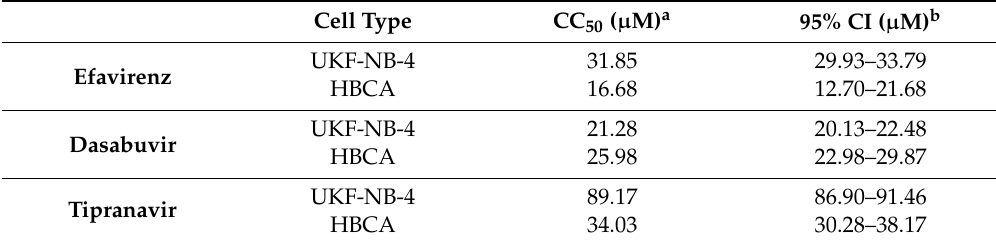
Table 3. Cytotoxicity characteristics of efavirenz, tipranavir, and dasabuvir in UKF-NB-4 and HBCA